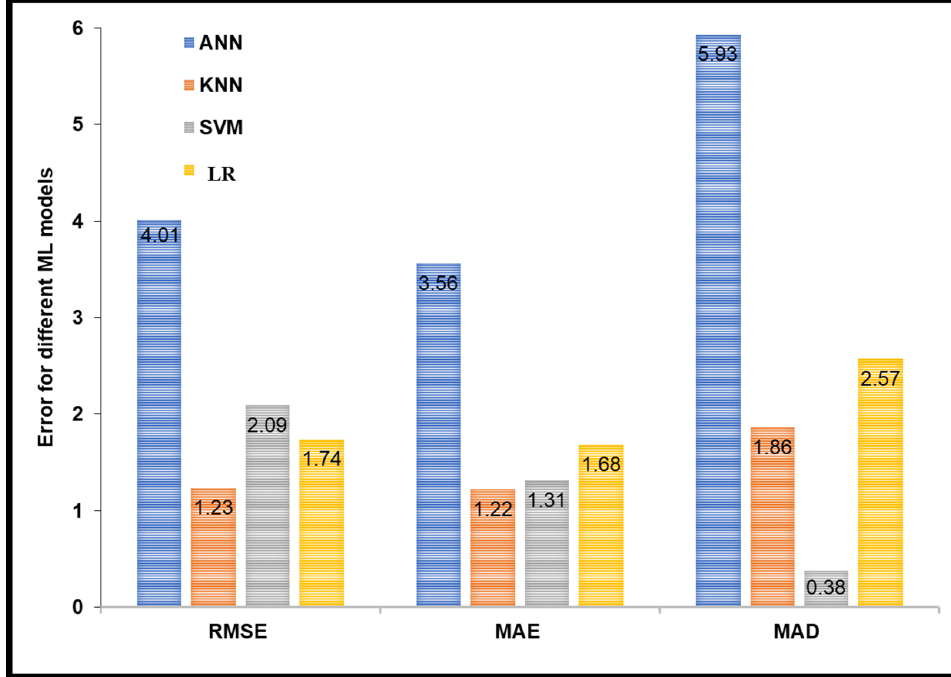
Figure 14. RMSE, MAE, and MAD error comparison for different ML models.